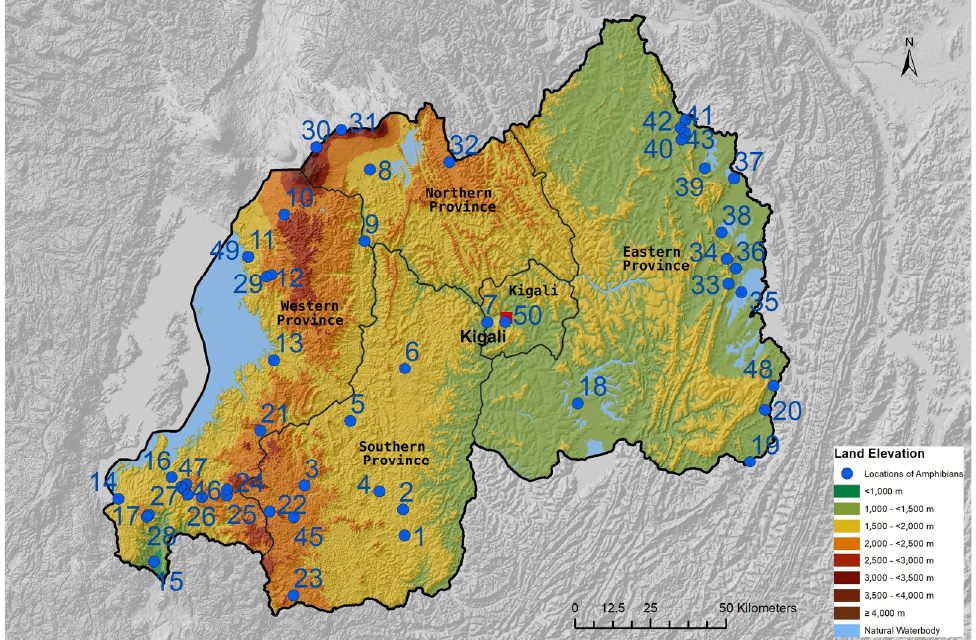
Figure 1. Physical map of Rwanda showing the 50 main sampling localities in the 5 provinces.